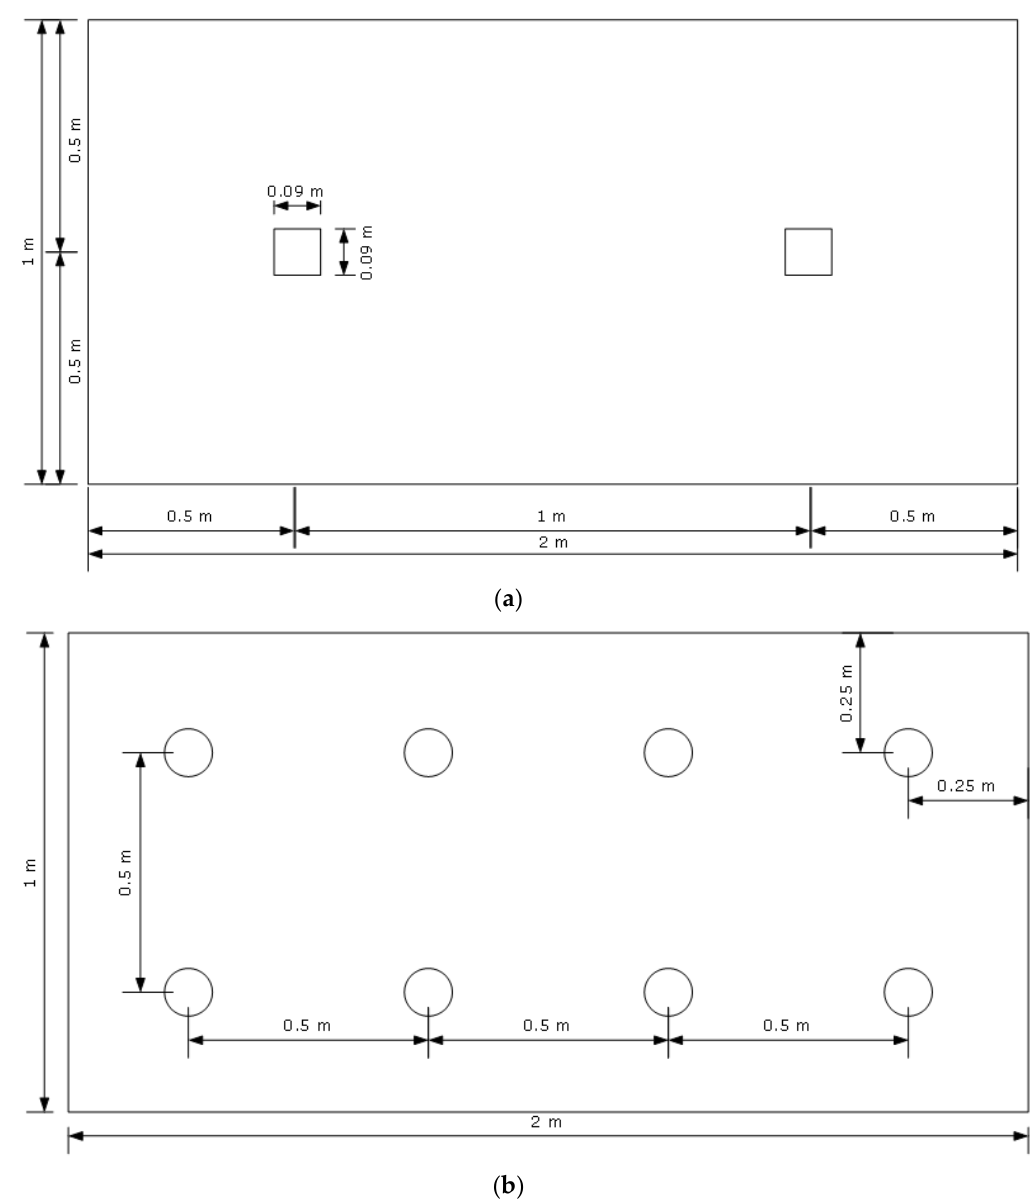
Figure 5. Layout of experimental unit: ( a ) LED luminaire layout; ( b ) Photo sensor layout.